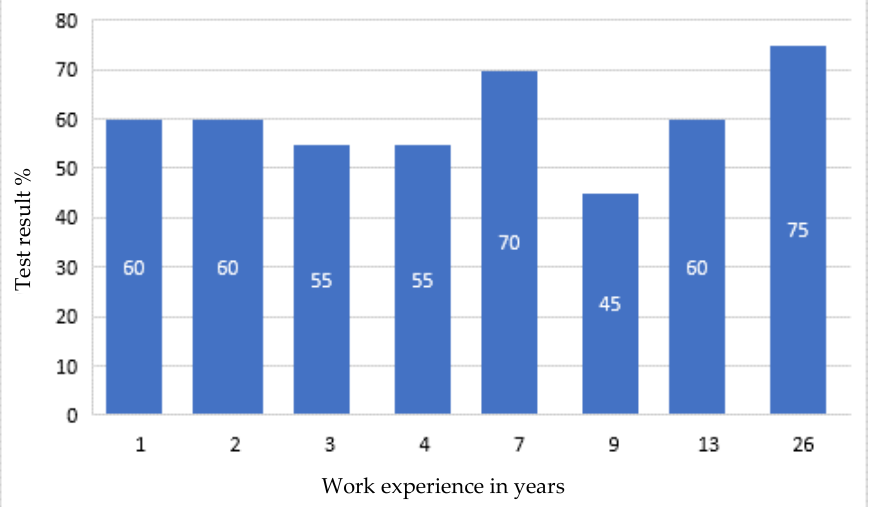
Figure 1. Research results regarding the operation of the conveyor belt, depending on professional experience.